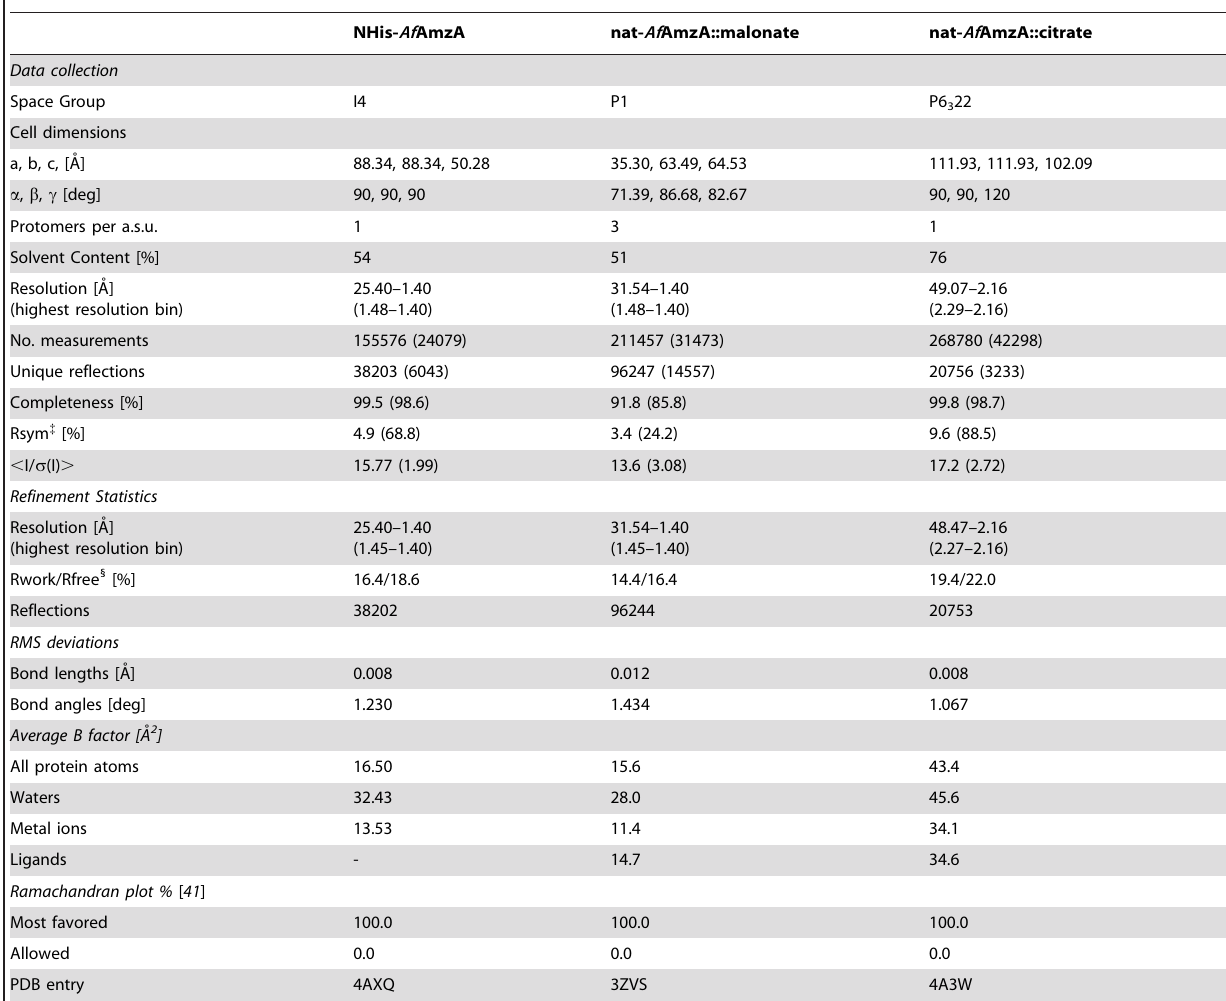
Table 1. Data collection and refinement statistics.